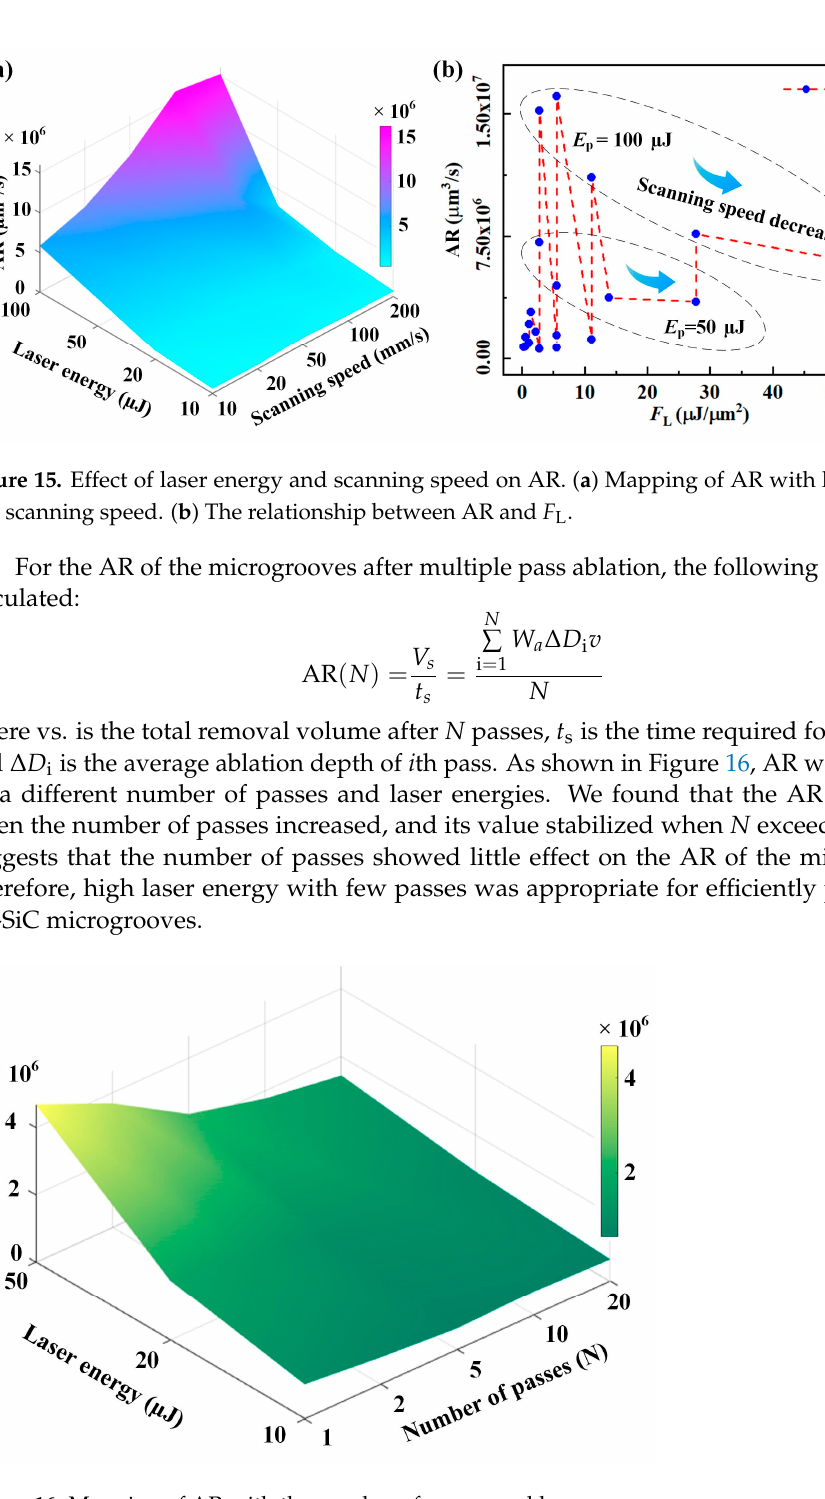
Figure 15. E ff ect of laser energy and scanning speed on AR. ( a ) Mapping of AR with laser energy and scanning speed. ( b ) The relationship between AR and F L .